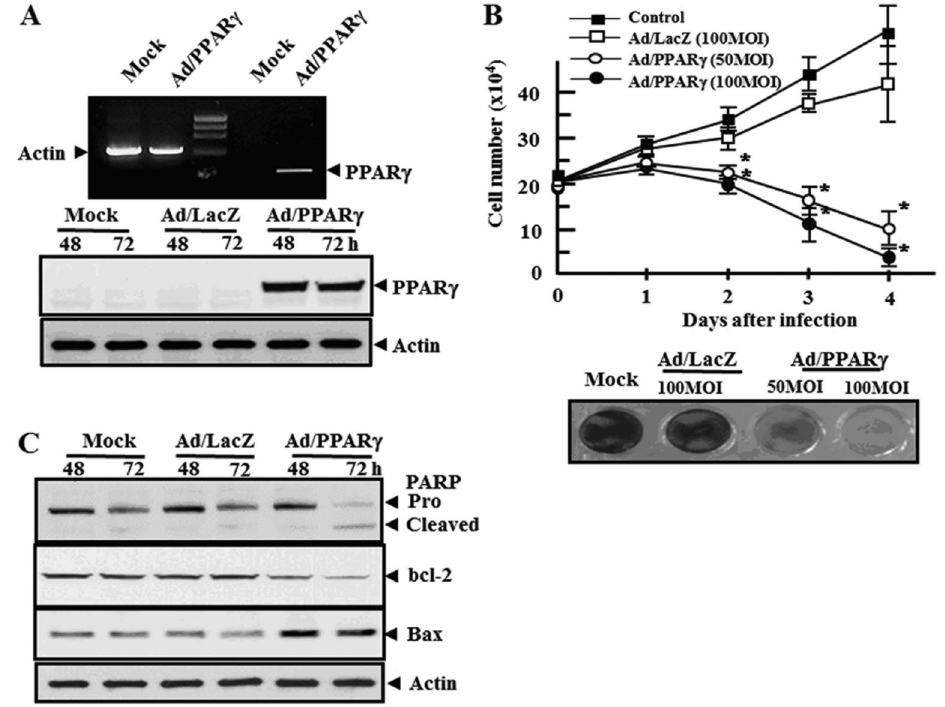
Figure 1. Effect of peroxisome proliferator activator receptor-gamma (PPAR c ) overexpression on cell growth and apoptosis. A , Analysis of PPAR c expression (upper panel, RT-PCR) and PPAR c protein (lower panel, Western blot) in SNU-668 cells infected with adenovirus- expressing(Ad)/PPAR c . B ,InhibitionofcellgrowthinSNU-668cellsinfectedwithAd/PPAR c . Upperpanel , CellswereinfectedwithAd/PPAR c or Ad/LacZ at the indicated MOI for 4 h and then allowed to grow under standard culture conditions for a further 4 days. Cell number was determined by direct counting after trypan blue staining. Data are reported as means±SD of 3 independent experiments. *P , 0.05 compared to control cells (Student’s t -test). Lower panel , Crystal violet assay. Cell growth in mock-treated and Ad/LacZ-treated cells compared to cells treated with Ad/PPAR c . C , Effect of PPAR c overexpression on PARP, Bcl-2 and Bax in SNU-668 cells infected with Ad/PPAR c . Cell lysates were collected and processed at 48 and 72 h after infection, and total protein was analyzed by Western ligand blot with specific